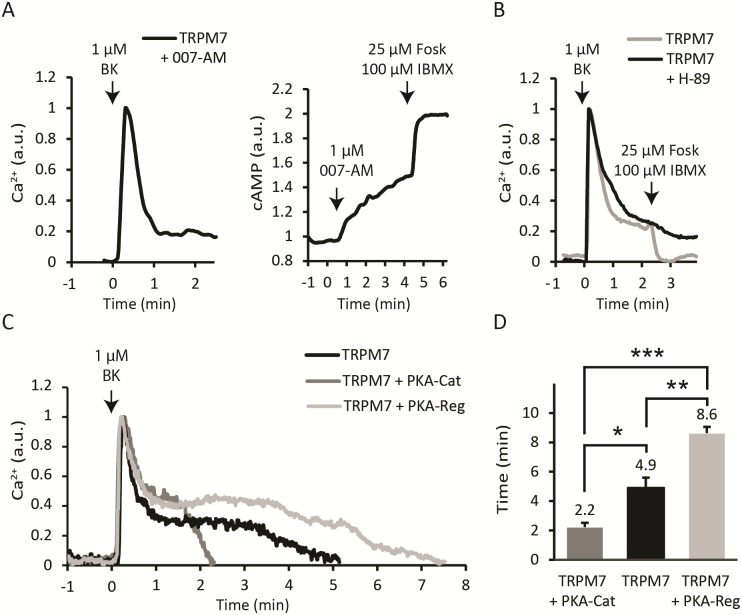
Involvement of PKA in the abrogation of Ca2+ influx.(A) Left panel, pretreatment with the Epac-selective cAMP analogue 007-AM (1 μM, 5 minutes) did not affect the sustained influx in 12/12 cells, p<0.001. Right panel, 007-AM activates the Epac FRET biosensor, verifying its biological activity in 30/30 cells, p<0.001. (B) Pretreatment with PKA inhibitor H-89 (10 μM, 5 minutes) largely blocked sensitivity of Ca2+ influx to cAMP, as addition of IBMX/forskolin during the sustained phase was without effect. (C) Overexpressing either PKA-Cat or PKA-Reg significantly affected the duration of the sustained Ca2+ influx. The left panel shows that the sustained Ca2+ influx of TRPM7 alone (black) lasted approximately 5 minutes. Overexpressing the catalytic subunit (dark grey) reduced the duration of the influx to approximately 2 minutes. Conversely, overexpressing the regulatory subunit (light grey) prolonged the influx to approximately 8 minutes. Representative traces from a single experiment are shown; data are quantified in the right panel. *, p < 0.05; **, p<0.01; ***, p<0.001.